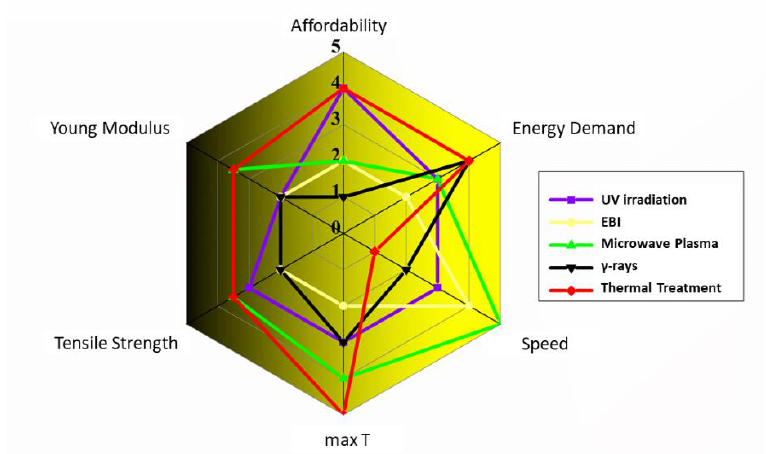
Figure 7. Comparison of the oxidation technologies for preparation of high-performance CFs.